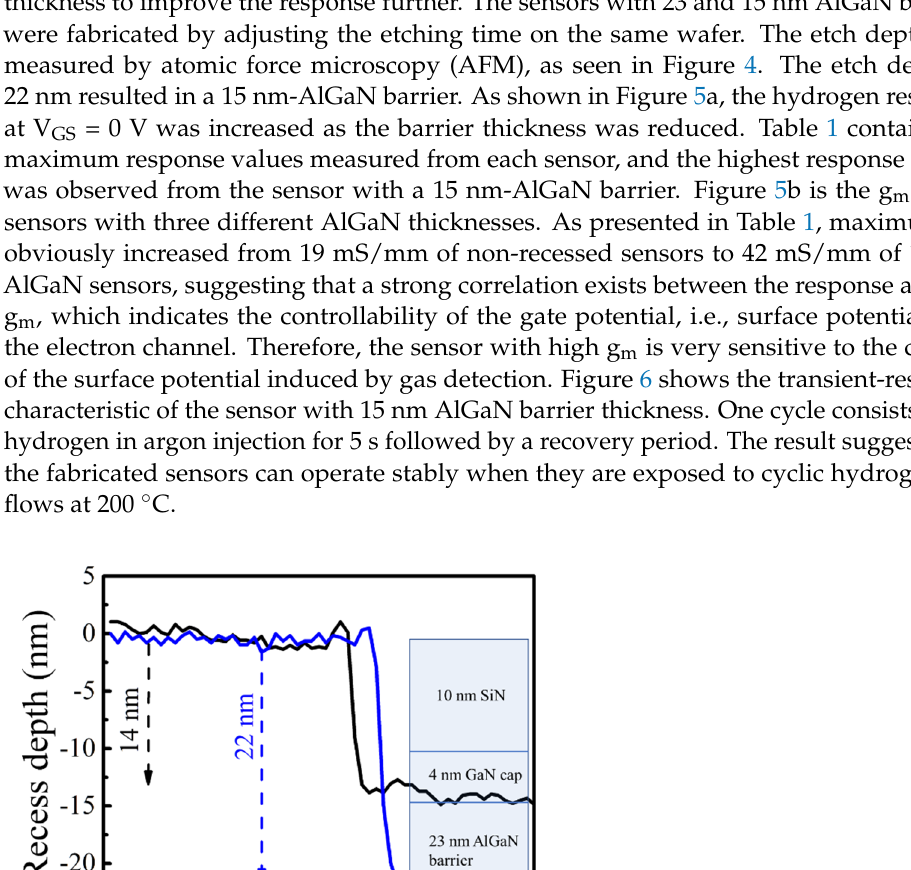
Figure 3. The comparison of responses between a floating gate and V GS = 0 V of a standard Pt/Al- GaN/GaN HEMT-based sensor.